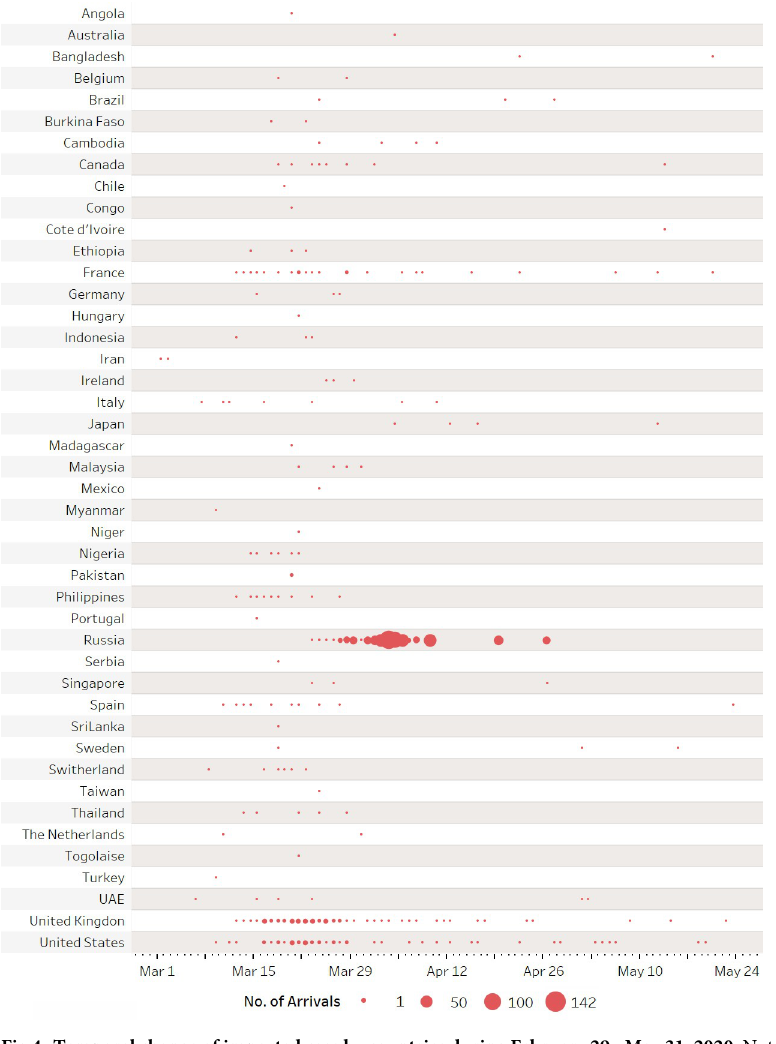
Fig 4. Temporal change of imported case by countries during February 29 –May 31, 2020. Note: The summary was based on the date of arrival. The number of importations from Russia is relatively concentrated and large, while the ones from the severely affected countries such as the U.K., the U.S. and France lasted longer.